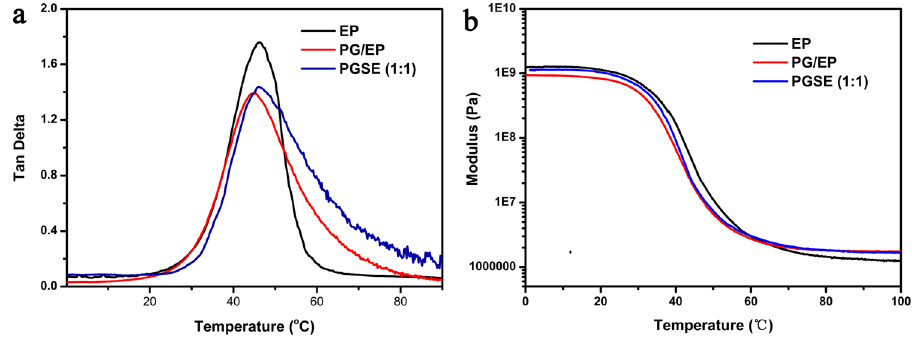
Figure 9. Dynamic mechanical properties of pristine EP, PG/EP with 10 wt% graphite sheets, and PGSE with 10 wt% graphite sheets and 3 wt% AgNWs, respectively: ( a ) tan delta, ( b ) storage